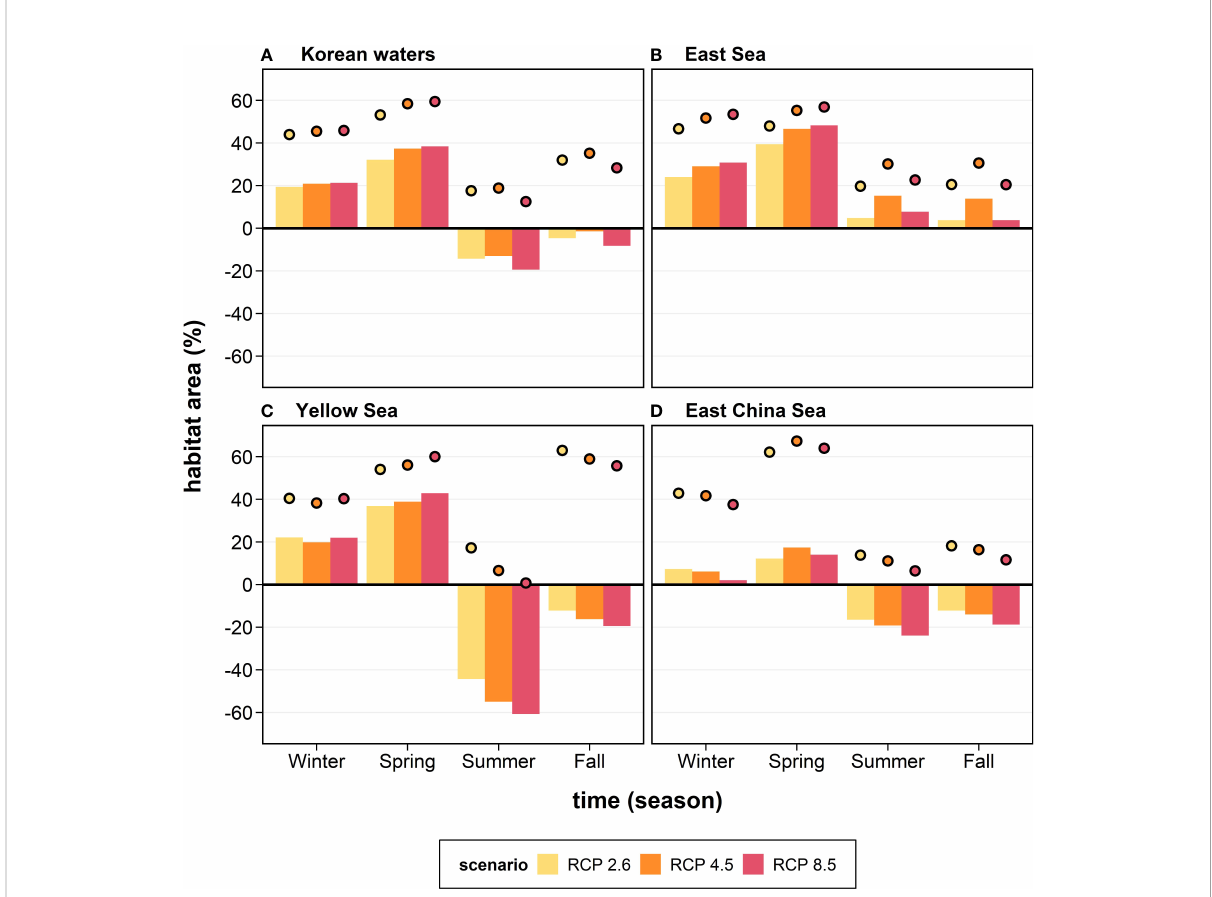
FIGURE 6 The anchovy habitat gain and loss (%; bars) in the future (the 2050s) under the three different future scenarios (colors) in each region: (A) Korean waters, (B) the East Sea, (C) the Yellow Sea, and (D) the East China Sea. The habitat gain and loss are the differences in the habitat area between future (the 2050s) and historical (2000 – 2015) periods divided by the total area of each region. The coverage (closed circles) of the future anchovy habitat (%) relative to the total area of each region is also